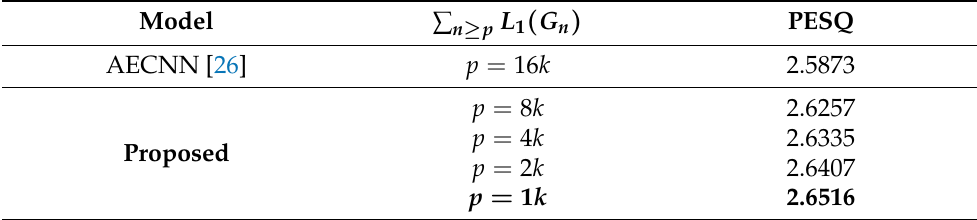
Table 2. Comparison of results between different architectures of the progressive generator. The best model is shown in bold type.